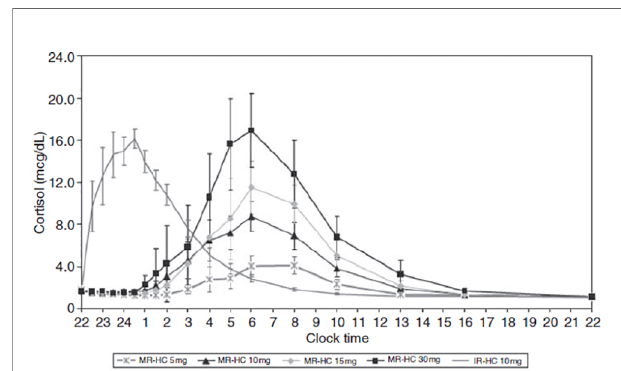
FIGURE 4 | Concentration-time pro fi les for modi fi ed-release hydrocortisone (MR-HC) 5mg, 10mg, 15mg and 30mg compared with immediate-release hydrocortisone (IRHC). Graph showing delayed and sustained release characteristic of MR-HC (to convert values from mcg/dl to nmol/l x 27.59). From Debono et al. (230). Modi fi ed-release hydrocortisone to provide circadian cortisol pro fi les. The Journal of Clinical Endocrinology & Metabolism, 94(5) ,